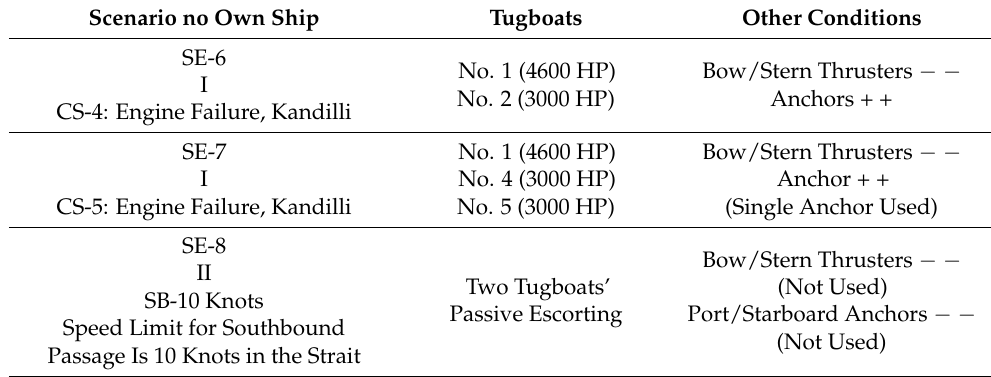
Own Ship Particulars: